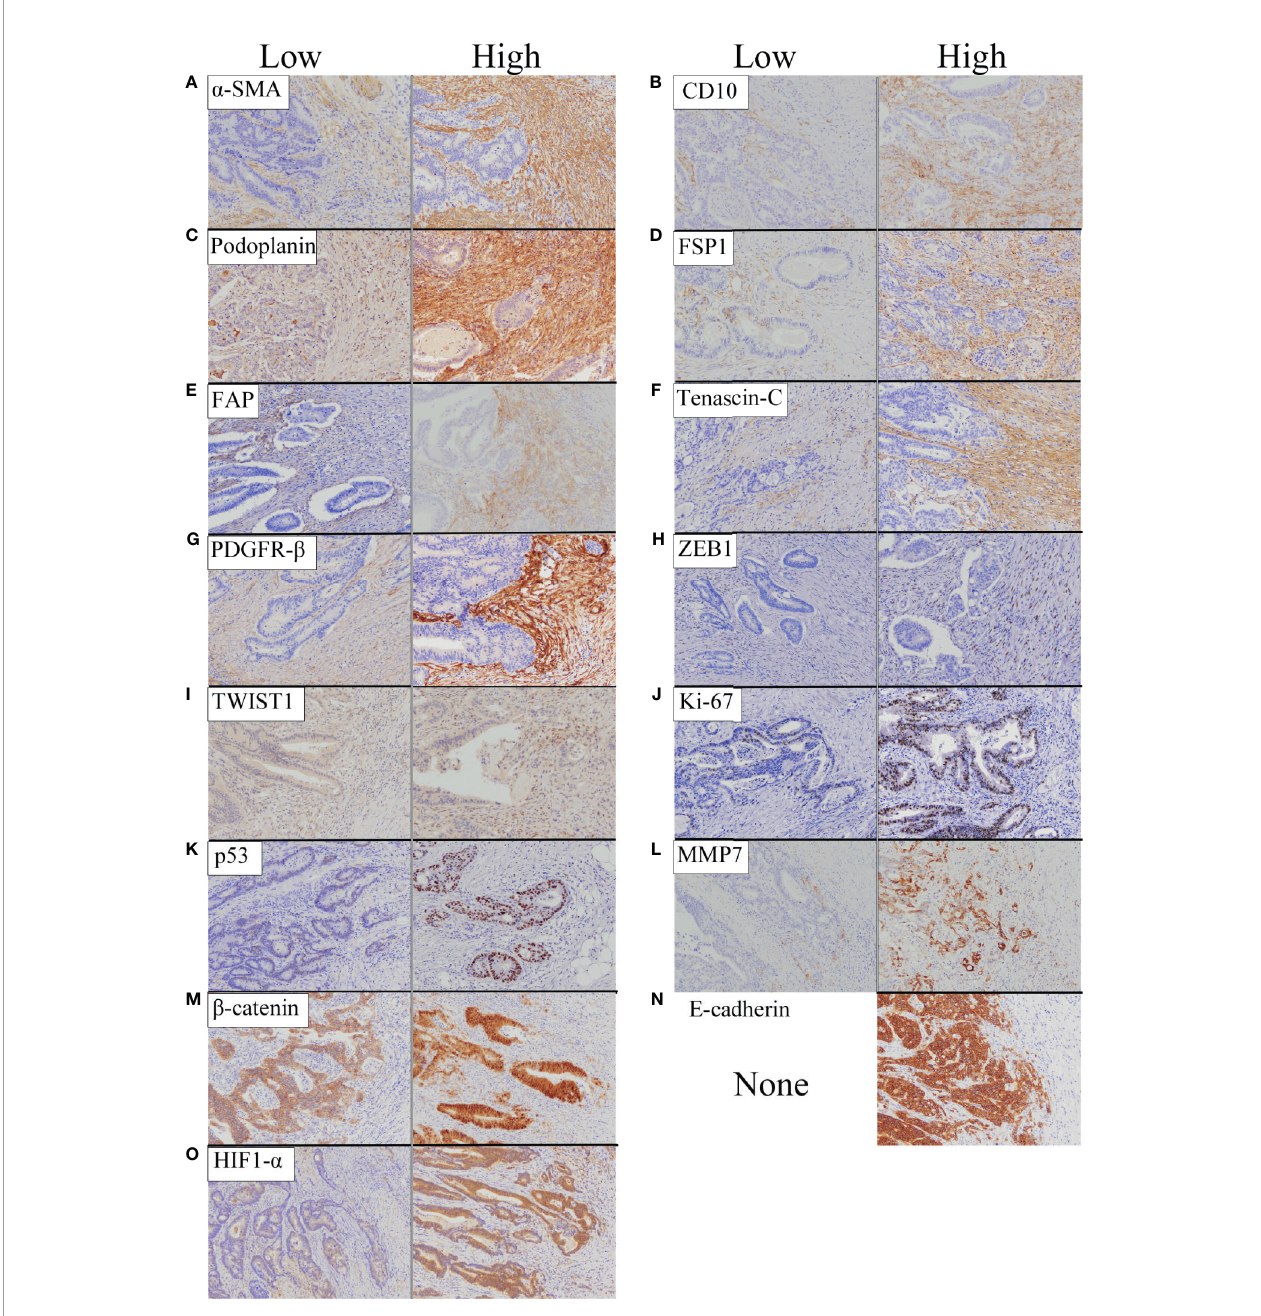
FIGURE 1 | Representative features of immunohistochemical staining of biological markers we examined based on expression level (low and high). (A) a -SMA. (B) CD10. (C) Podoplanin. (D) FSP1. (E) FAP. (F) Tenascin-C. (G) PDGFR- b . (H) ZEB1. (I) TWIST1. (J) Ki-67. (K) p53. (L) MMP7. (M) b -catenin. (N) E-cadherin. (O) HIF1- a